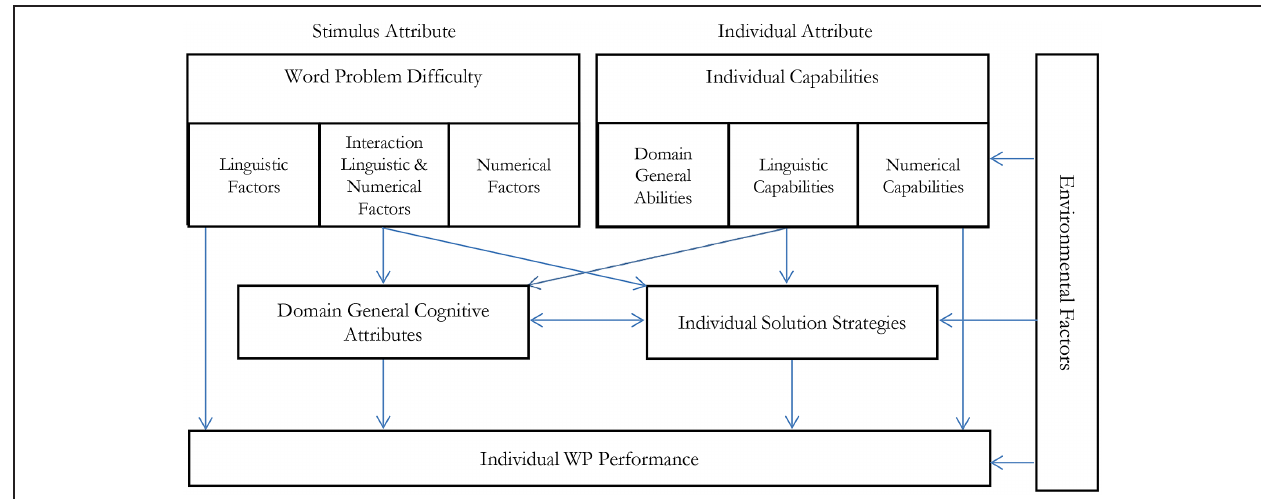
FIGURE 1 | This figure describes a possible theoretical process model of world problem solving based on this article and dissociating numerical and linguistic factors: Three general aspects are distinguished for predicting individual WP performance. Stimulus Attributes (WP difficulty), individual attributes (capabilities), and environmental factors (e.g., teaching). WP difficulty comprises linguistic factors (such as linguistic complexity of the WP text, Section 2 of this article), numerical factors (such as numerical difficulty of the numerical problem, Section 3), and their interaction (such as the relation between text and arithmetic problem, Section 4). Individual Capabilities can refer to linguistic and numerical capabilities and domain- general abilities such as individual working memory capacity. Stimulus attributes and individual attributes influence individual WP performance both directly and over two mediator variables. One mediator variable refers to domain-general attributes, such as